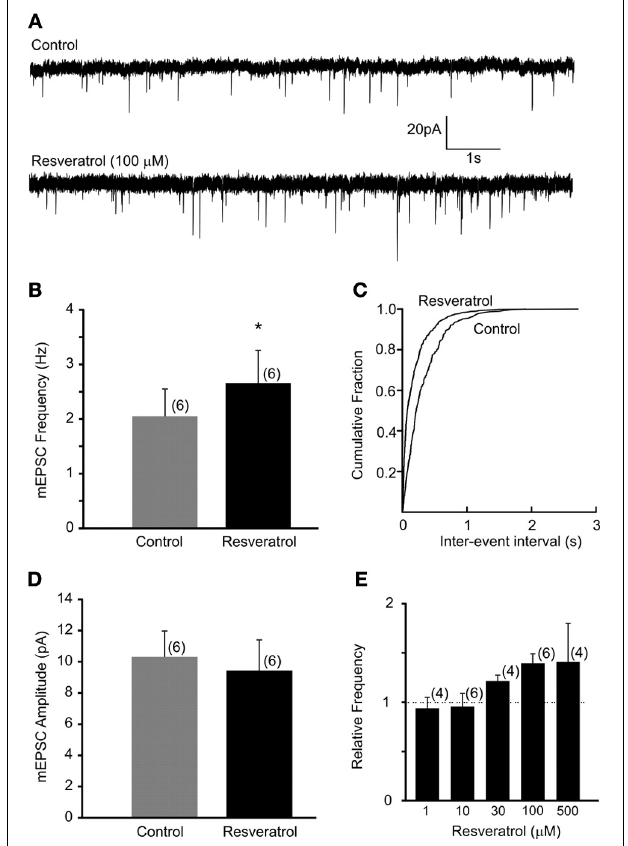
FIGURE 2 | Resveratrol enhanced miniature excitatory neurotransmission in DMV neurons. (A) Voltage-clamp recordings of mEPSCs from a DMV neuron before (upper trace) and after (lower trace) resveratrol application. (V m = − 60mV). (B) Combined data demonstrating that resveratrol increased mEPSC frequency. ∗ Significance ( p < 0 . 05). (C) Cumulative event probability plot of inter-event interval distribution in the recording shown in (A) . (D) Mean group data showing that resveratrol did not alter the amplitude of mEPSCs. (E) Histogram showing the concentration dependence of the response to resveratrol in DMV neurons. Number of replicates indicated at each concentration in parentheses. neurons ( p > 0 . 05) ( Figure 2E ). Application of 30 µ M